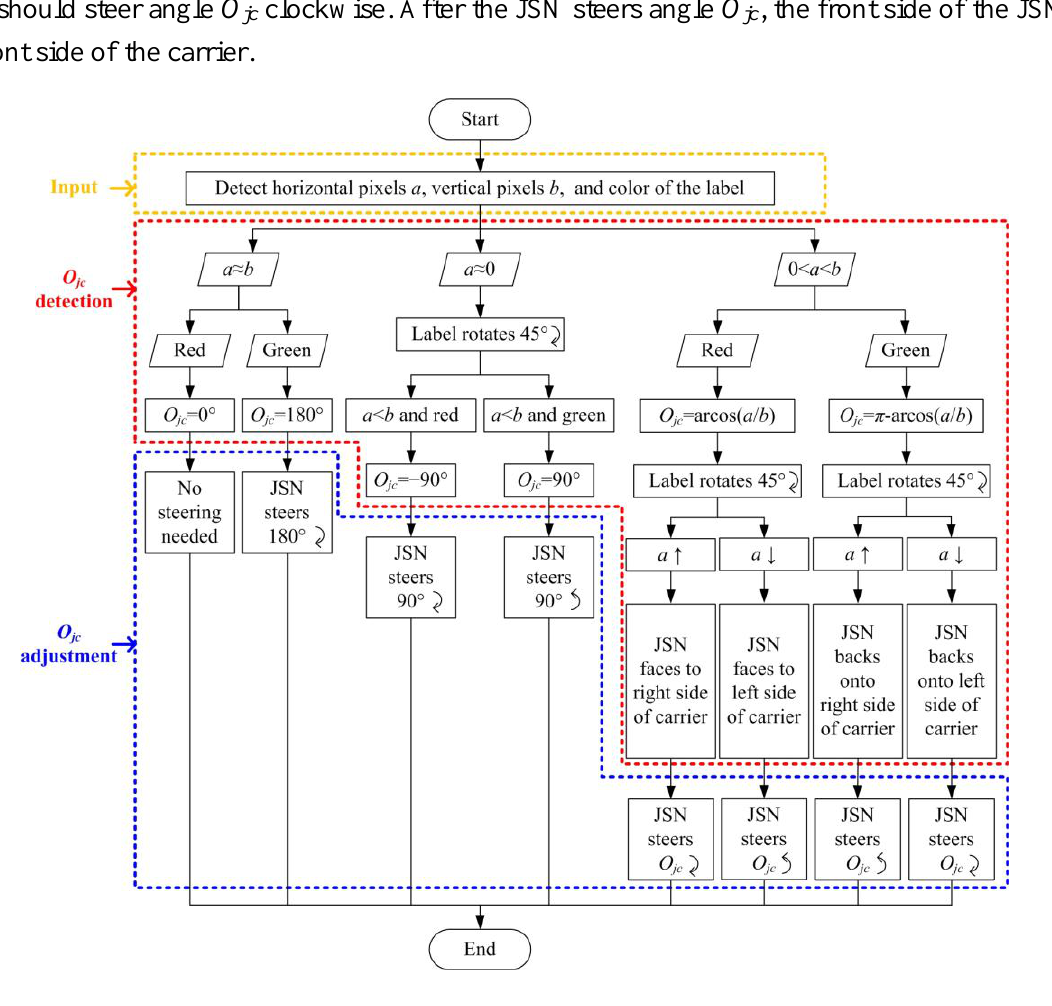
Figure 7. Algorithm for orientation O jc detection and adjustment of the JSN relative to the